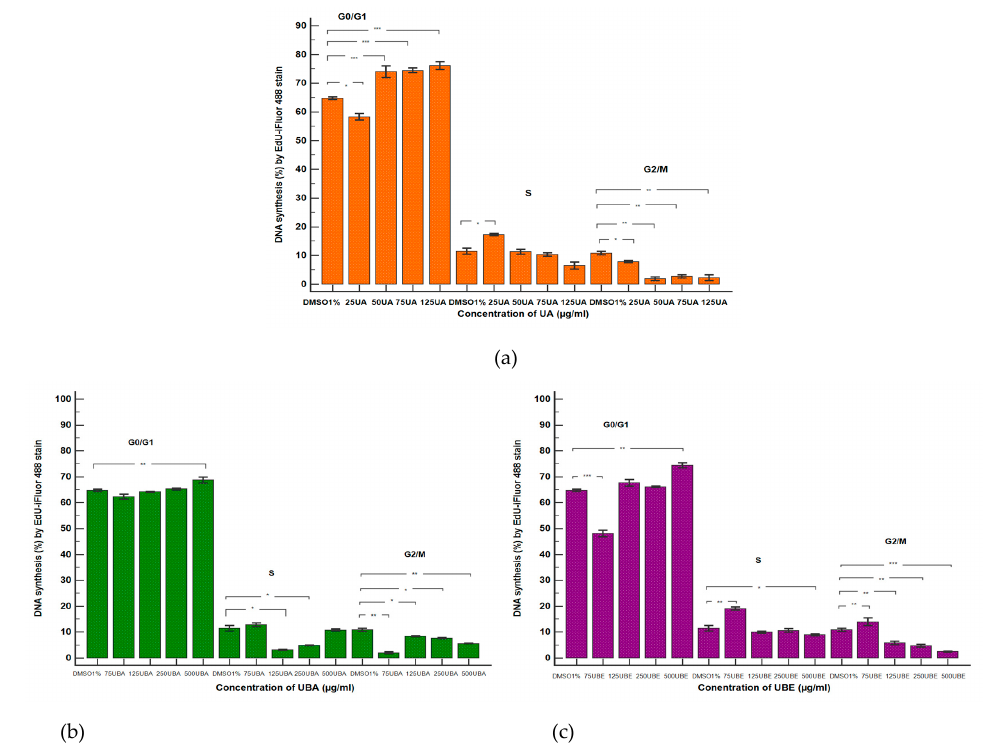
Figure 13. Cell proliferation status of UA, UBA, and UBE treatments in normal blood cell cultures. EdU-iFluor 488 patterns of UA 25, 50, 75, 125 μ g/mL ( A ( b – e )); ( B ( b – e )) UBA 75, 125, 250, 500 μ g/mL; ( C ( b – e )) UBE 75, 125, 250, 500 μ g/mL reported to 1% DMSO ( A ( a ), B ( a ), C ( a )).